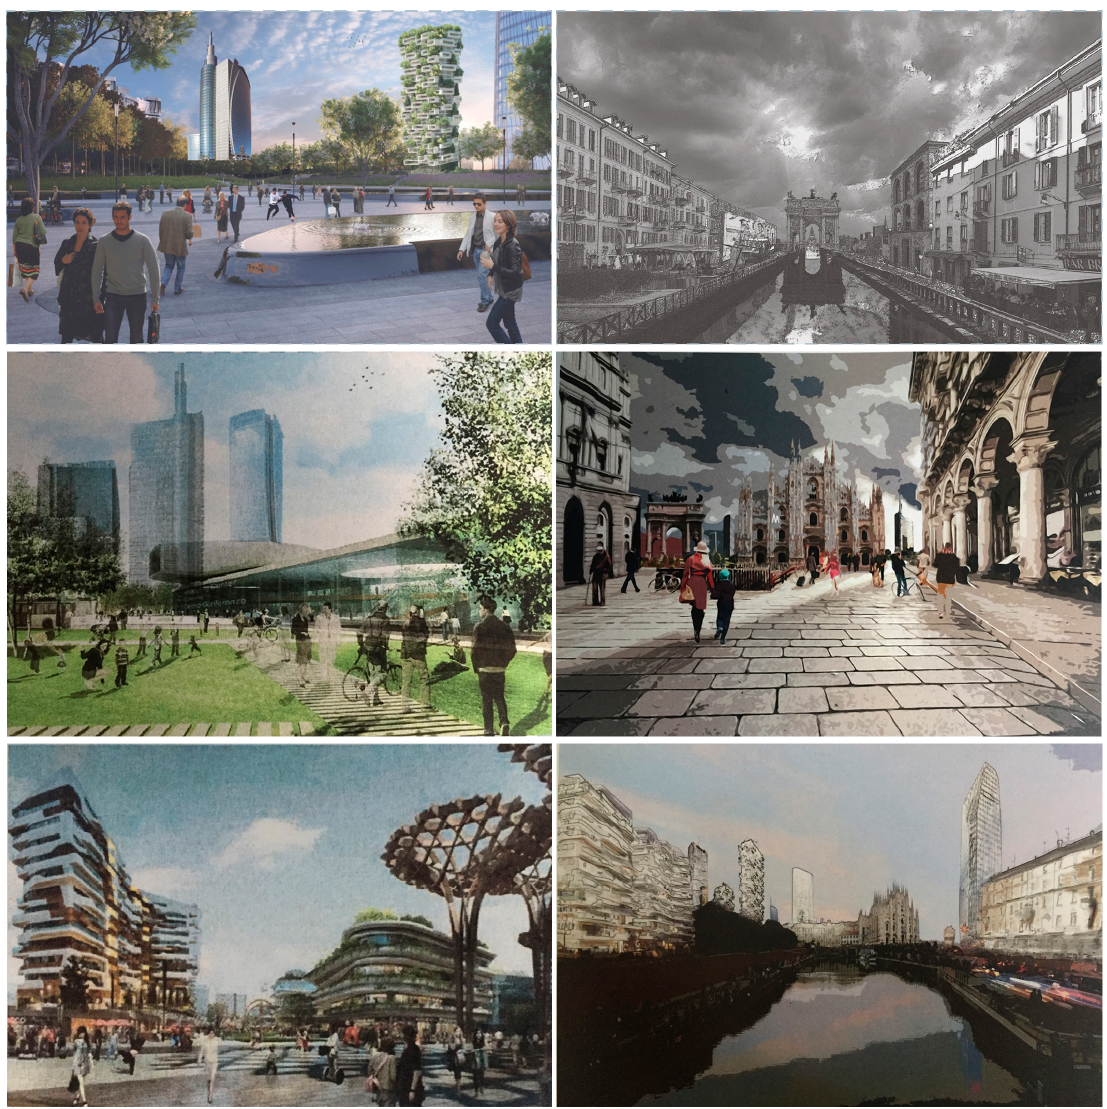
Figure 4. The antithetical views of the city. The images on the left side are designed by Chinese students, those on the right side by Italian